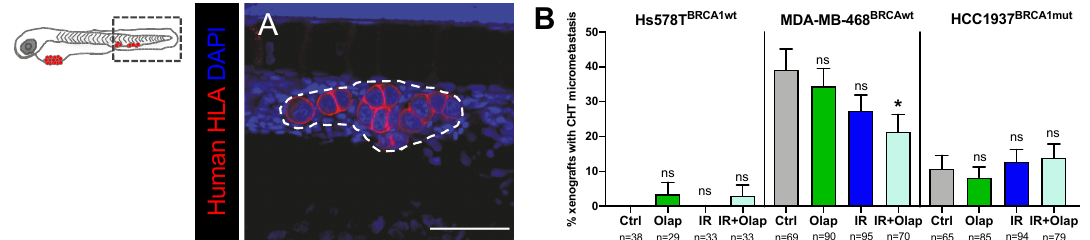
Figure 5. Metastatic potential of TNBC cell lines is modulated by olaparib and IR. TNBC (Hs578T BRCAwt , MDA-MB-469 BRCAwt and Hcc1937 BRCA1mut ) xenografts were generated as previously described and at 24 hpi, were screened and randomly distributed into the di ff erent experimental conditions: control, olaparib, IR, IR + olaparib. At 5dpi and 4 days post-treatment, xenografts were fixed to analyze the presence of micrometastasis in the caudal hematopoietic tissue (CHT) ( A ). Representative image of a micrometastasis in the CHT is labelled with anti-human-HLA–MHC-class (in red) for human cell identification. The dashed white line represents the micrometastasis area, scale bar: 50 µ m ( A ). The metastatic potential was quantified as the percentage of xenografts that present micrometastasis in the CHT at 5dpi ( B ). Results are from three independent experiments and expressed as mean ± SEM. The total number of xenografts analyzed is indicated below the chart. Statistical results: ns > 0.05, * p ≤